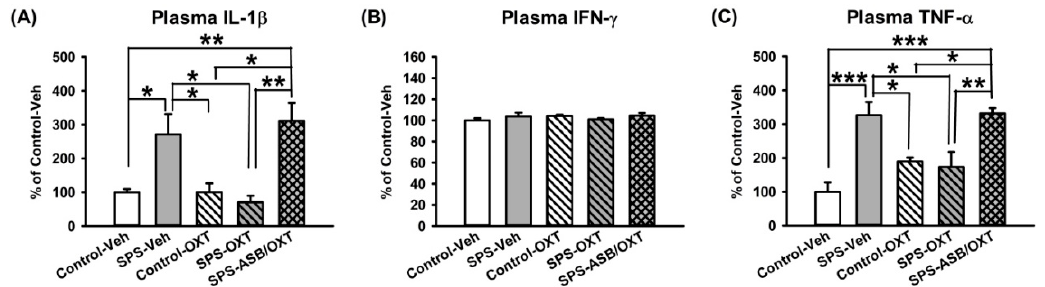
Figure 6. Peripheral IL-1 β , IFN- γ , and TNF- α levels. OXT reversed SPS-induced increment of plasma IL-1 β and TNF- α levels, and ASB seemed to block this effect with marginal significance ( A , C ). However, IFN- γ was shown to be insensitive to SPS, OXT, and ASB ( B ). n = 4 for each group; SPS: single prolonged stress, Veh: vehicle, OXT: oxytocin, ASB: atosiban. Bars represent mean ± SEM; * p < 0.05, ** p < 0.01, *** p < 0.001.